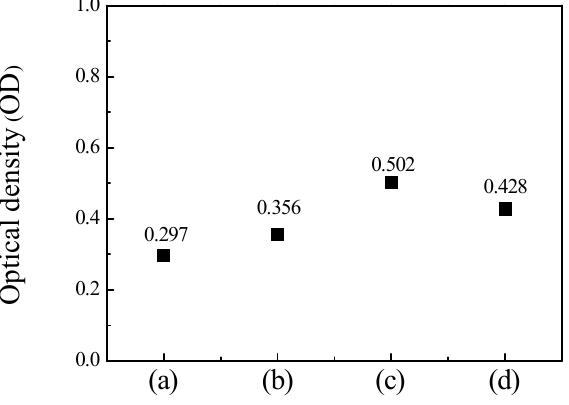
Figure 7. Transmittance variation ( T bleached – T colored ) of ECDs: ( a ) WO 3 ; ( b ) LW1; ( c ) LW2; ( d ) LW3.